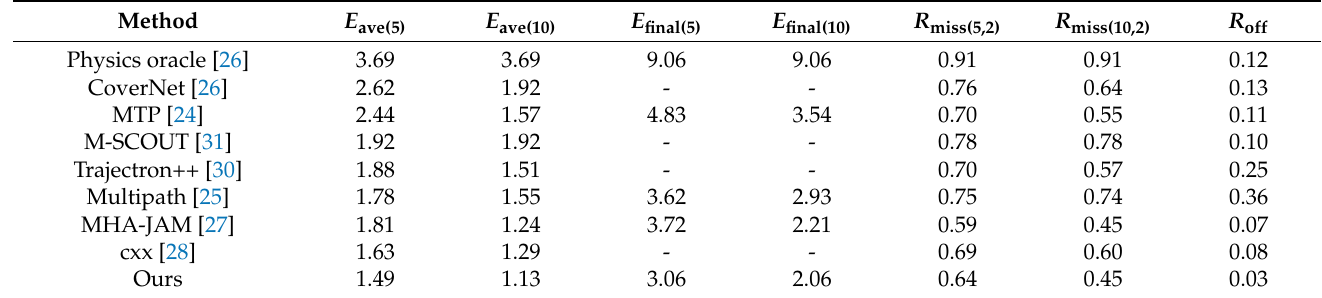
Table 3. Comparative analysis on nuScenes dataset over a prediction horizon of